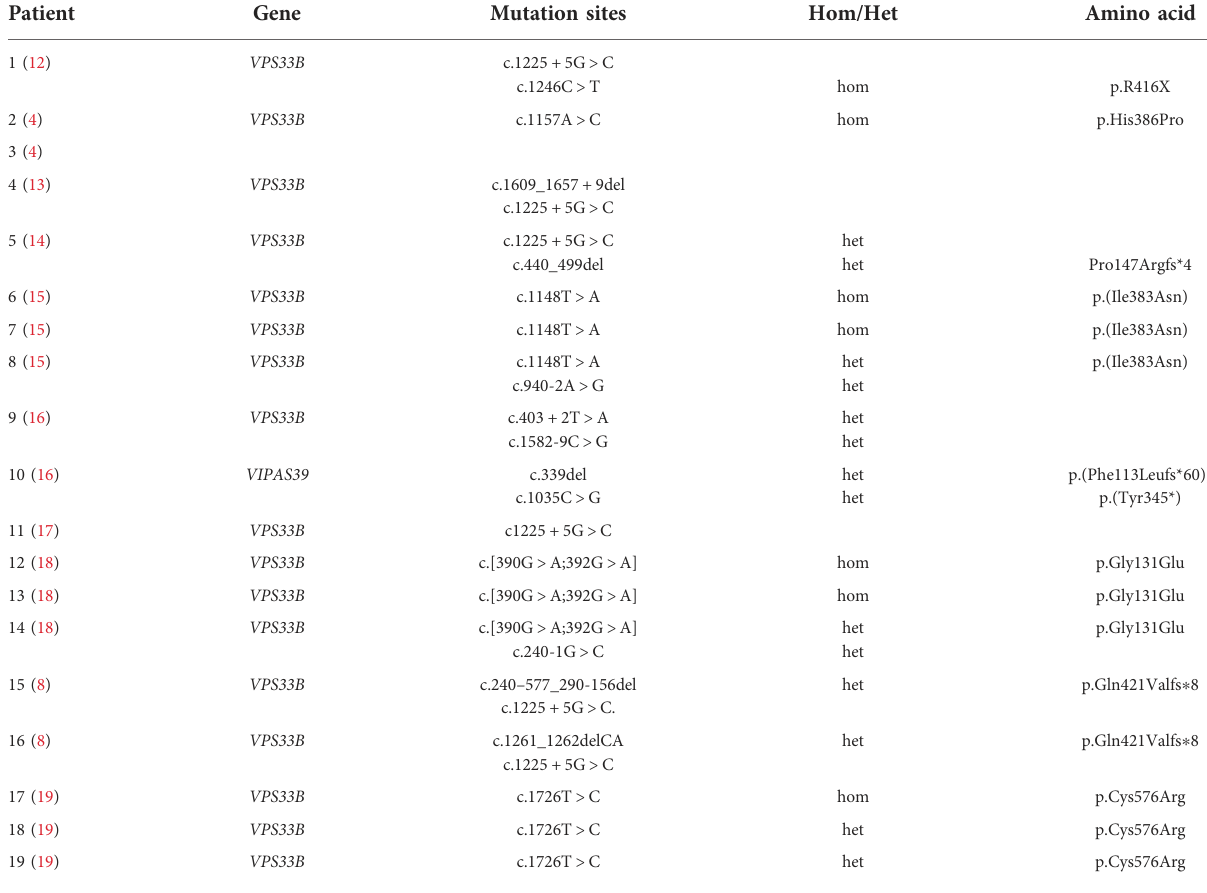
TABLE 3 Currently known VPS33B gene mutation sites associated with prolonged survival in ARC